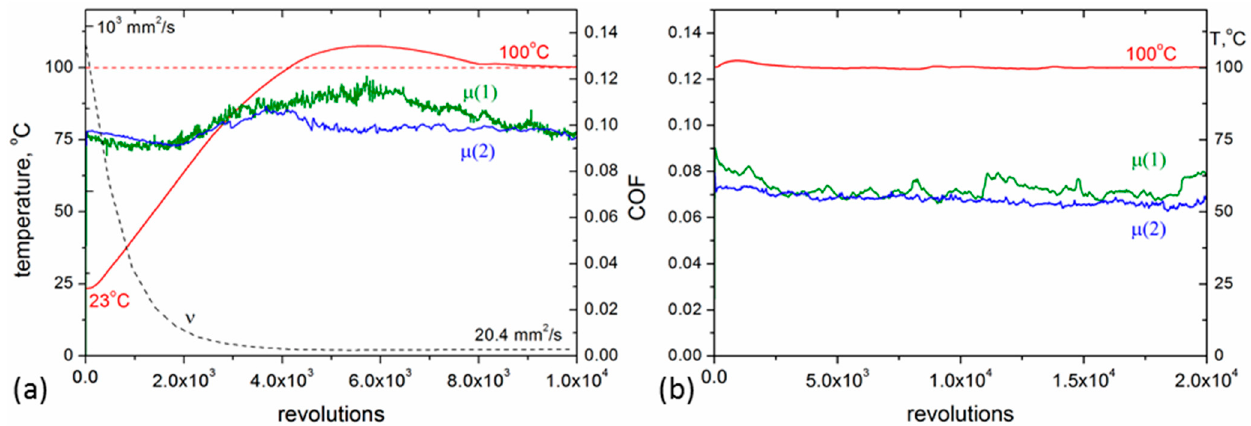
Figure 9. ( a ) Change in the temperature of the DLN sample during heating from T = 23 °C to T = 100 °C and corresponding change of the friction coefficient in the two tests of lubricated sliding on the laser-textured film; the oil viscosity data (taken from [29]) replotted vs sliding distance is shown by a dashed curve. ( b ) Lubricated friction performance of the laser-textured film at T = 100 °C; load 1 N, sliding speed 5 cm/s. Two series of the successive lubricated sliding tests, corresponding to the friction curves μ (1) and μ (2) in both ( a ) and ( b ), were made at the same sliding track of R = 3 mm.